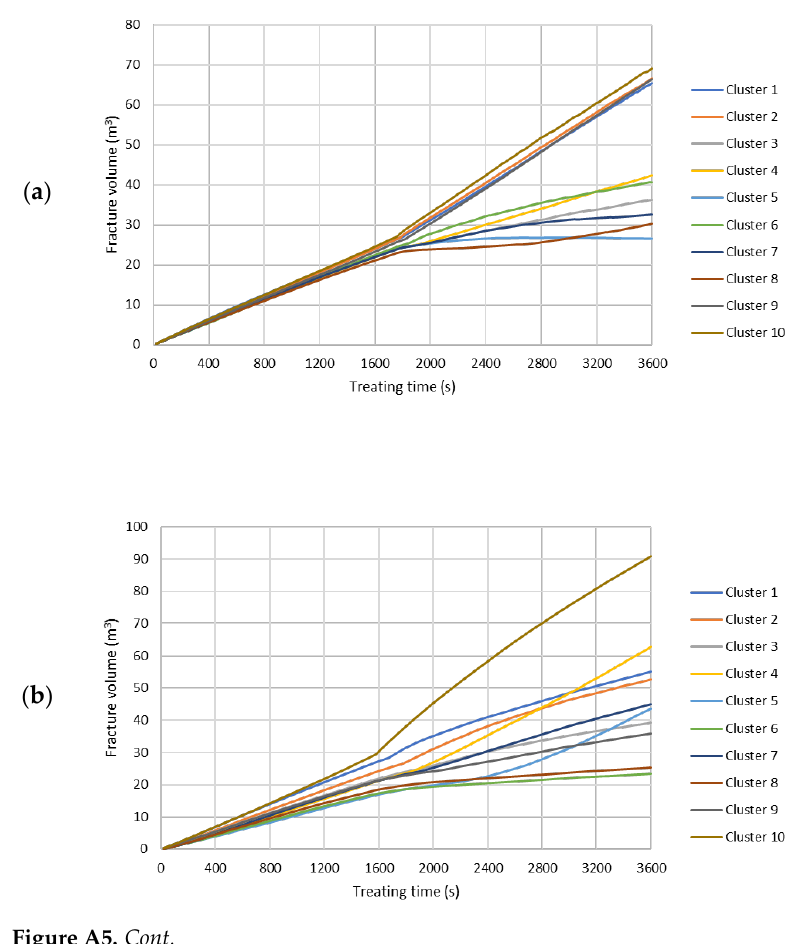
Figure A5. Fracture volume of each cluster during the hydraulic fracturing treatment. ( a ) Slick water case. ( b ) NG foam case. ( c ) Hybrid NG/NG foam case.